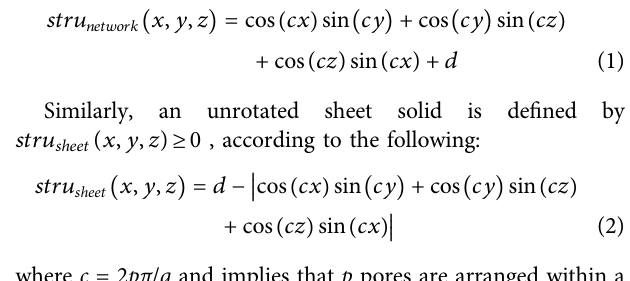
Frontiers in Physics |